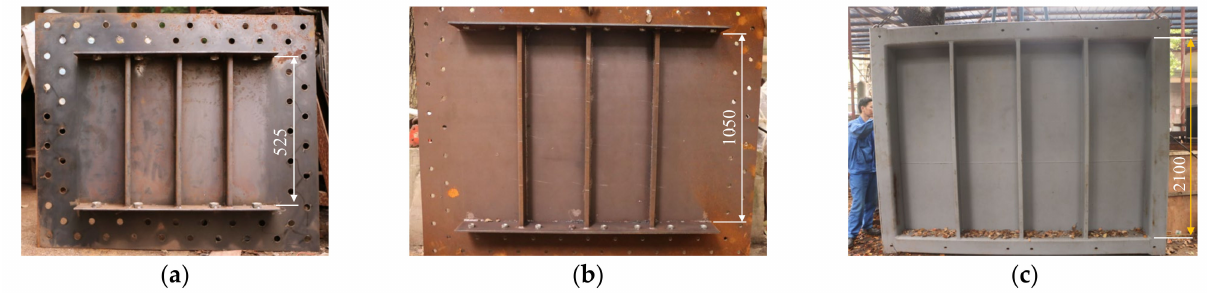
Figure 2. Photographs of the specimens (unit: mm): ( a ) 1:4 scaled model; ( b ) 1:2 scaled model; ( c ) full-scaled prototype.